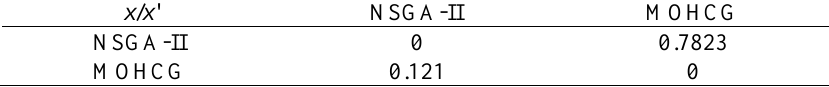
Table 9 . Coverage of two sets average value for small-sized problems x / x